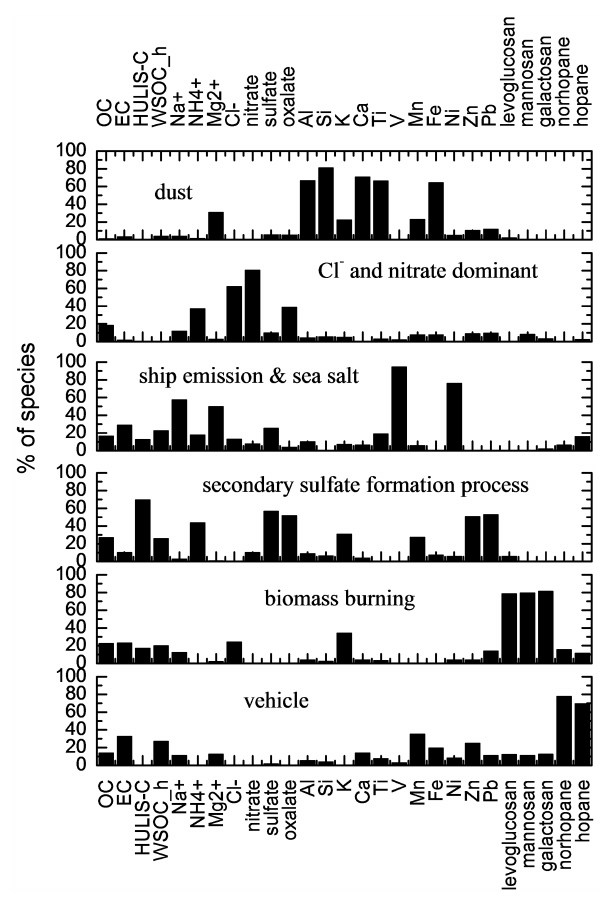
Figure 5. Explained variation of the factors apportioned by